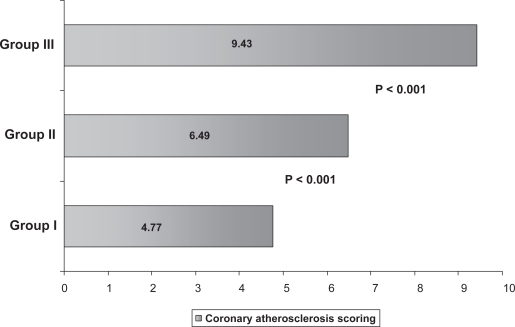
Severity scoring of CAD in different age groups.